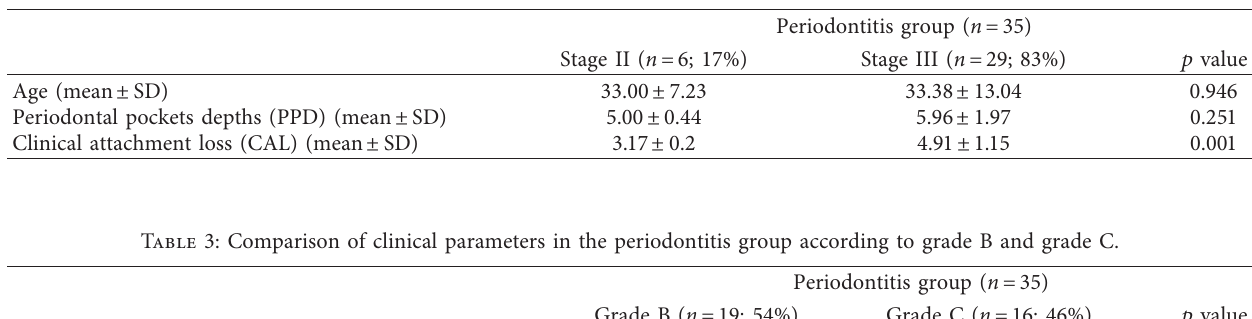
Table 2: Comparison of clinical parameters in the periodontitis group according to stages II and stage III.